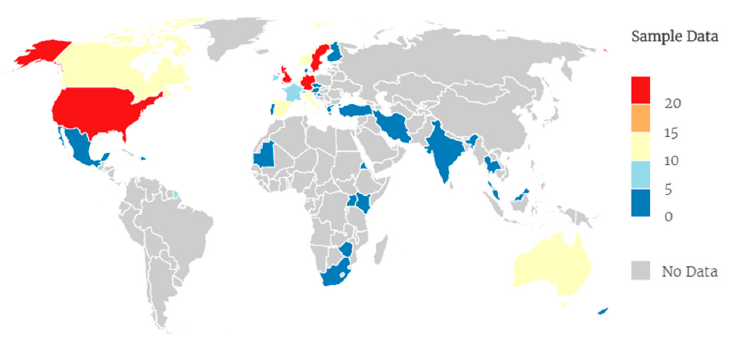
Figure 5. Geographical distribution by country of scientific production in relation to unaccompanied minors.